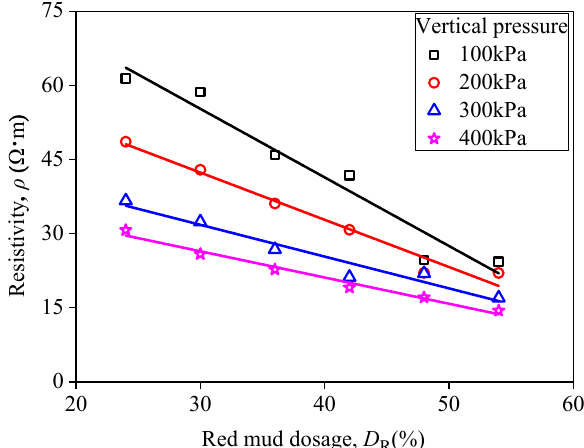
14 of 22 Figure 18. Relationship between resistivity and unconfined compressive strength. 3.5.2. Direct Shear Parameter Figure 19 depicts curves of resistivity of RMLS mixture with D R under different ver- tical pressures at the curing age of 3 d . It is observed that resistivity decreases as D R in-